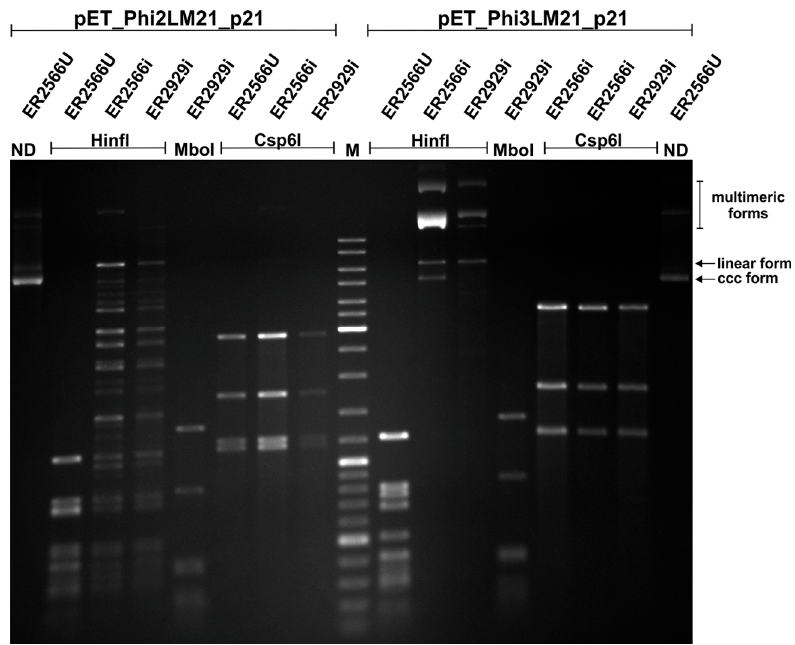
Figure 2. Comparative restriction patterns of the pET_Phi2LM21_p21 and pET_Phi3LM21_p21 plasmid DNAs prepared from Escherichia coli ER2566 or ER2929 cells grown in the presence (ER2566i or ER2929i, respectively) or absence (ER2566U) of inducer IPTG and cleaved with selected restriction endonucleases ( Hinf I, Mbo I or Csp6 I). Digest mixtures were electrophoresed on 0.8% agarose gel and stained with ethidium bromide. M—GeneRuler 100–10,000 bp size marker (Thermo Fisher Scientific, Waltham, MA, USA). The bands corresponding to supercoiled (ccc) and linear forms of the pET_Phi3LM21_p21 plasmid, as well as its multimeric forms were indicated.